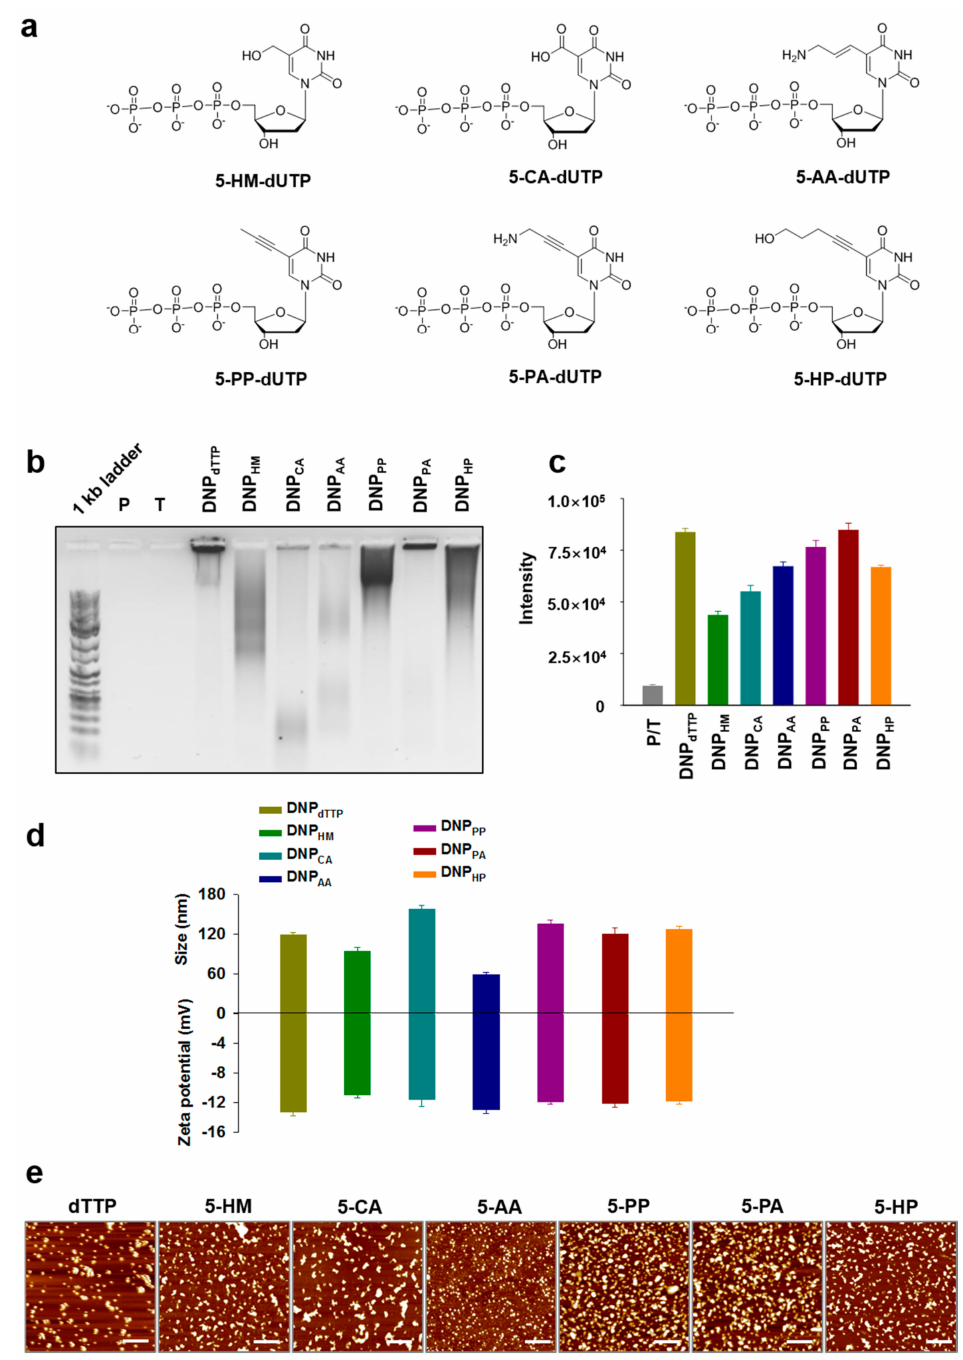
Figure 2. ( a ) Chemical structures of C5-modified nucleotides incorporated into DNA nanoparticles (DNPs). ( b ) Agarose gel (0.5%) analysis of RCA-produced DNPs (P: primer, T: circular template). ( c ) Fluorescence intensity of the DNPs stained with SYBR gold. ( d ) Dynamic light scattering (DLS) analysis showing hydrodynamic sizes of DNPs and zeta potential values of DNPs. ( e ) Atomic force microscopy (AFM) images of DNPs. The scale bar: 1 µ